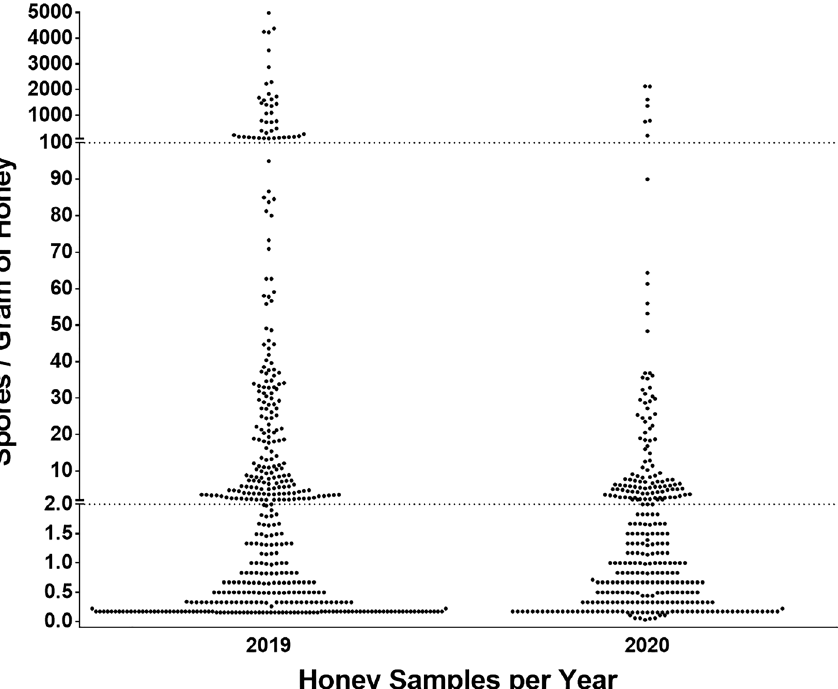
Figure 1. Samples of pooled, extracted honey with detectable spores of Paenibacillus larvae . Plotted values represent 753 honey samples (out of 1476) collected from both small-scale (S) and large-scale (L) beekeepers across two honey-producing seasons (2019–2020) that had detectable spores of P. larvae (range = 0.1–4983 spores per gram of honey). Samples with no detectable spores are not plotted. Dotted lines represent intuitive visual breakpoints (thresholds) with cut-off values delimiting categories of spore contamination where two spores per gram of honey differentiates low from moderate concentrations and 100 spores per gram of honey differentiates moderate from high concentrations.